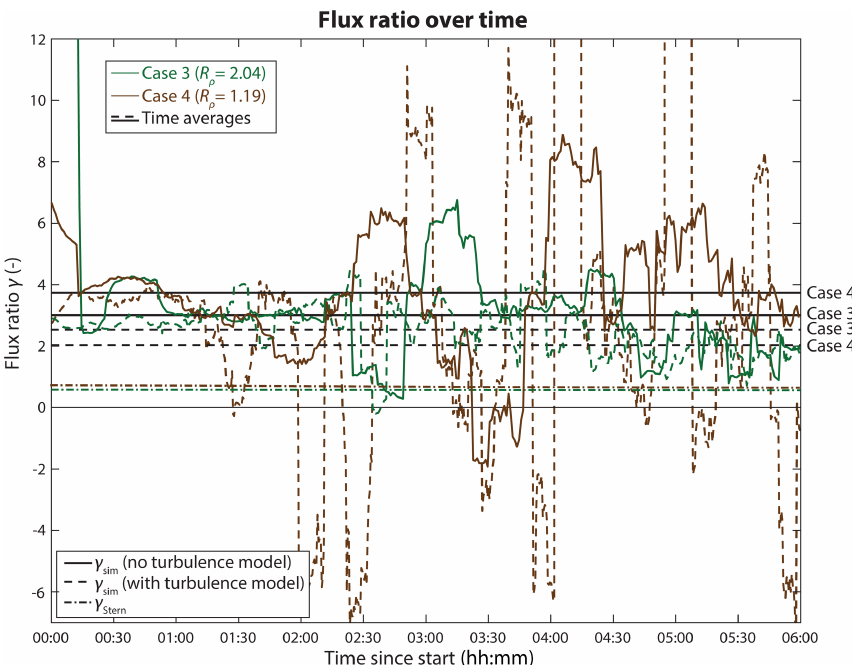
Figure 12. The evolution of flux ratios over time for R ρ simulations without a turbulence model, and dotted lines marks the simulations with a turbulence model. The black lines mark the temporal averages for each simulation.